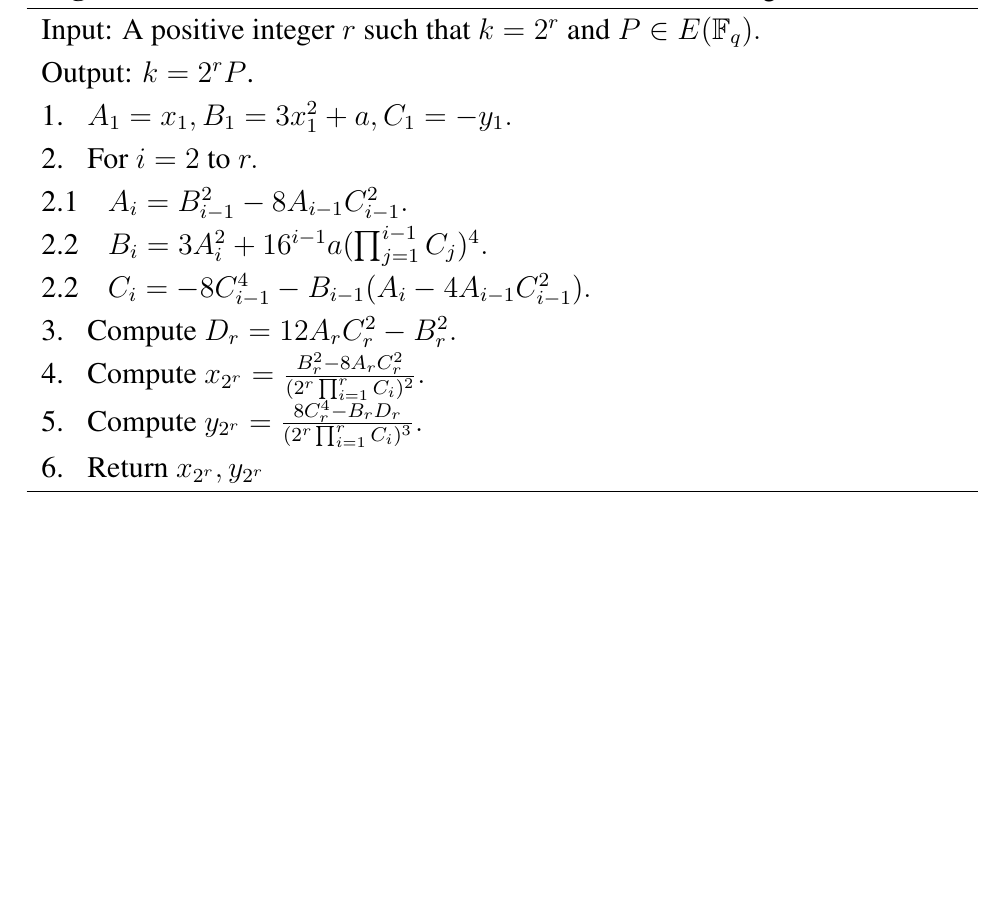
Algorithm 6. Sakai and Sakurai’s method for direct